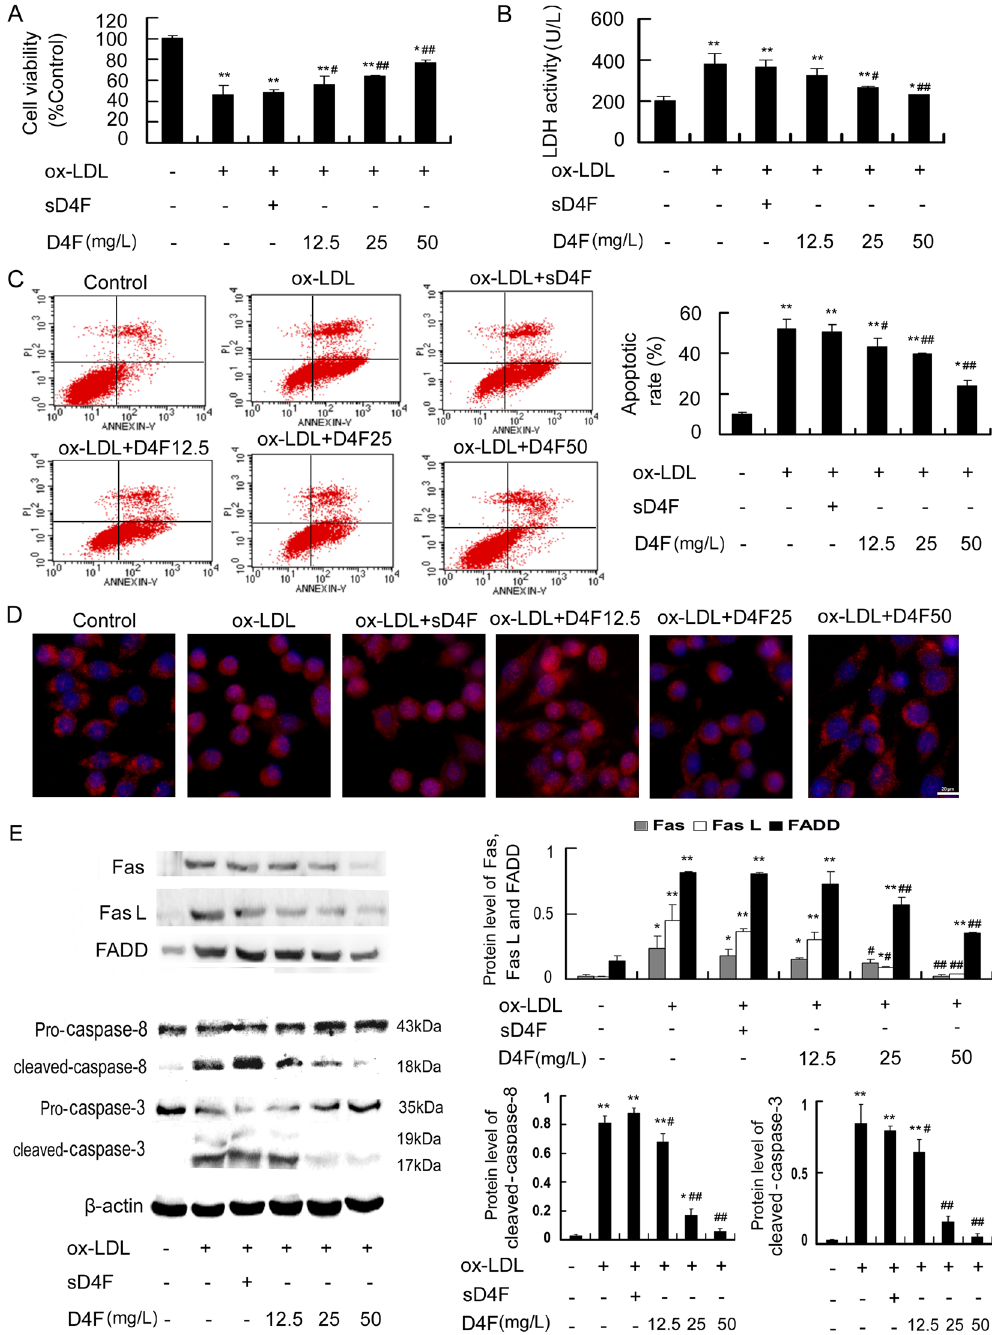
Figure 3. D4F attenuates apoptosis, P65 nuclear translocation and the activation of Fas/FasL pathway in RAW264.7 cells induced by ox-LDL. RAW264.7 cells were pretreated with D4F (12.5, 25 and 50 mg/L) or scrambled D4F (sD4F, 50 mg/L), the inactive control peptide, for 1 h followed by incubation with ox-LDL (100 mg/L) for 24 h. Cell viability ( A ), LDH activity in the media ( B ) and cell apoptosis ( C ) were measured using the MTT assay, a kit and flow cytometry, respectively. ( D ) Immunofluorescence experiments revealed the expression of P65, which was labeled by Cy3 (red), and nuclei, which were stained with DAPI (blue). Representative fluorescent images are shown. Scale bar = 20 μ m. ( E ) The protein levels of Fas/FasL pathway- related molecules were analyzed by Western blot. Data are expressed as the mean ± SD of at least three independent experiments. * P < 0.05 and ** P < 0.01 versus vehicle-treated control; # P < 0.05 and ## P < 0.01 versus ox-LDL